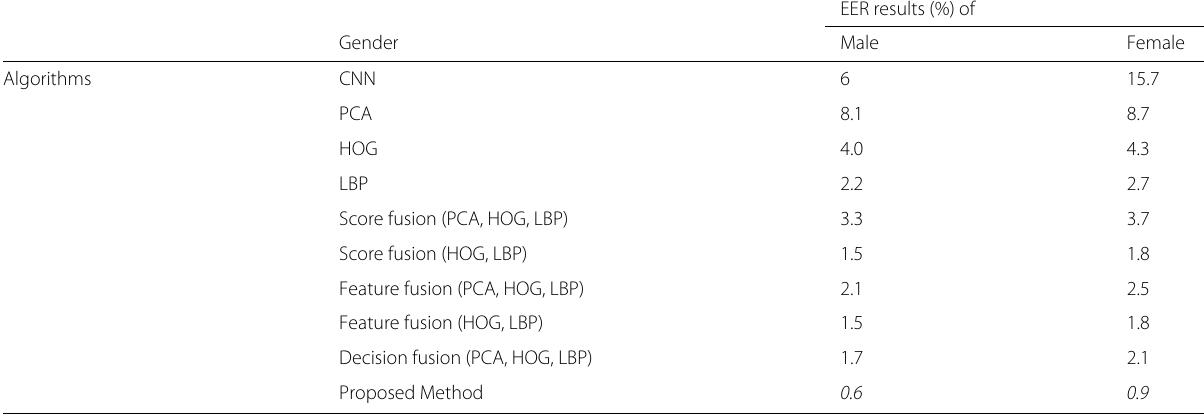
Table 6 EER results of gender-based experiments for identical twins Implemented algorithms